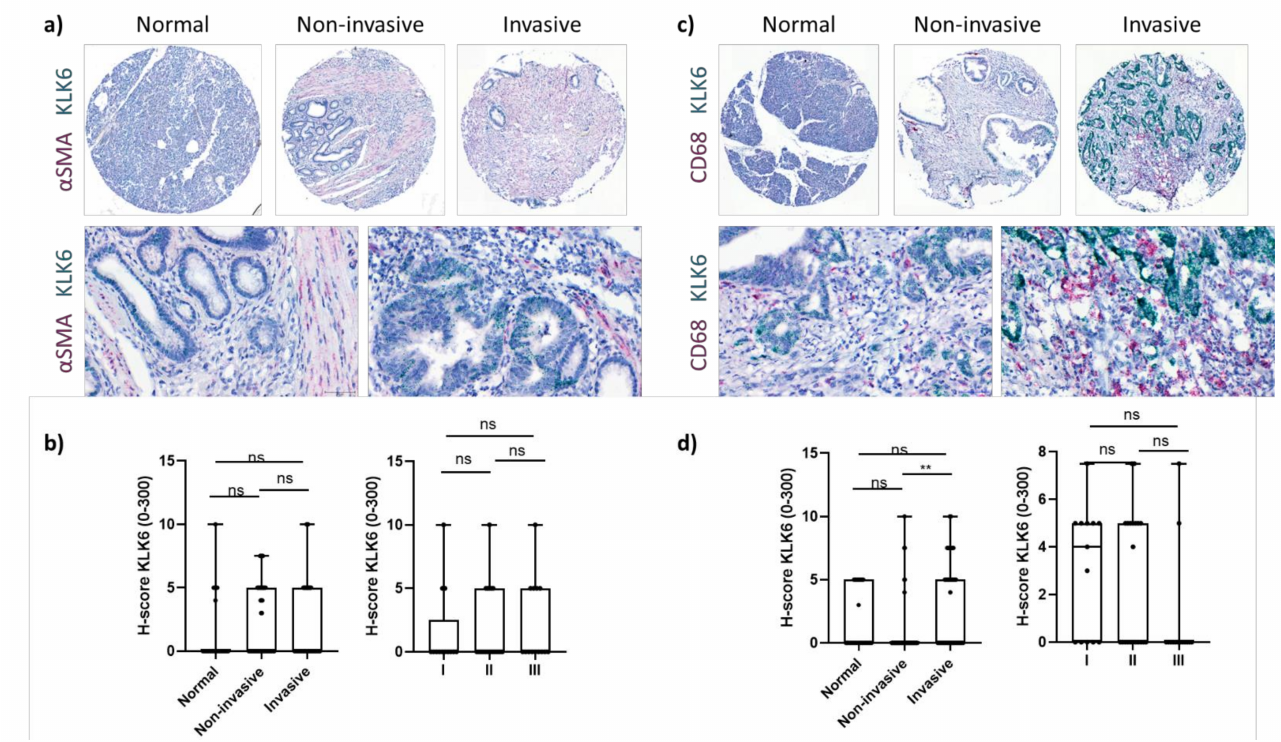
Figure 3. KLK6 mRNA expression in PDAC tissues. ( a ) Representative images of dual in situ hybridisation of KLK6 (green) and α SMA (red) in normal pancreas and PDAC tissues. ( b ) KLK6 was expressed by stromal cells at very low levels and did not correlate with (non)invasive tumour areas and tumour stage. ( c ) Representative images of dual in situ hybridisation of KLK6 (green) and CD68 (red) in normal pancreas and PDAC tissues. ( d ) KLK6 was expressed by CD68+ cells at very low levels and correlated with invasive tumour areas compared to the noninvasive counterparts. Asterisks indicate statistical significance (** p ≤ 0.01; ns, not